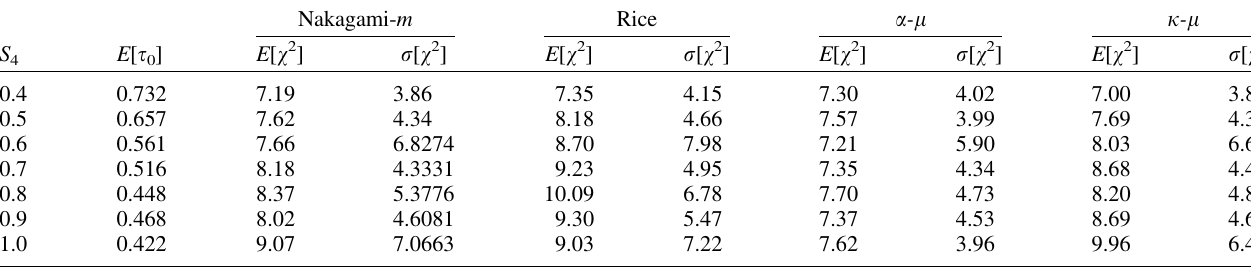
Table 2. E [ v 2 ] and r [ v 2 ] results as functions of S 4 for different models. Nakagami-